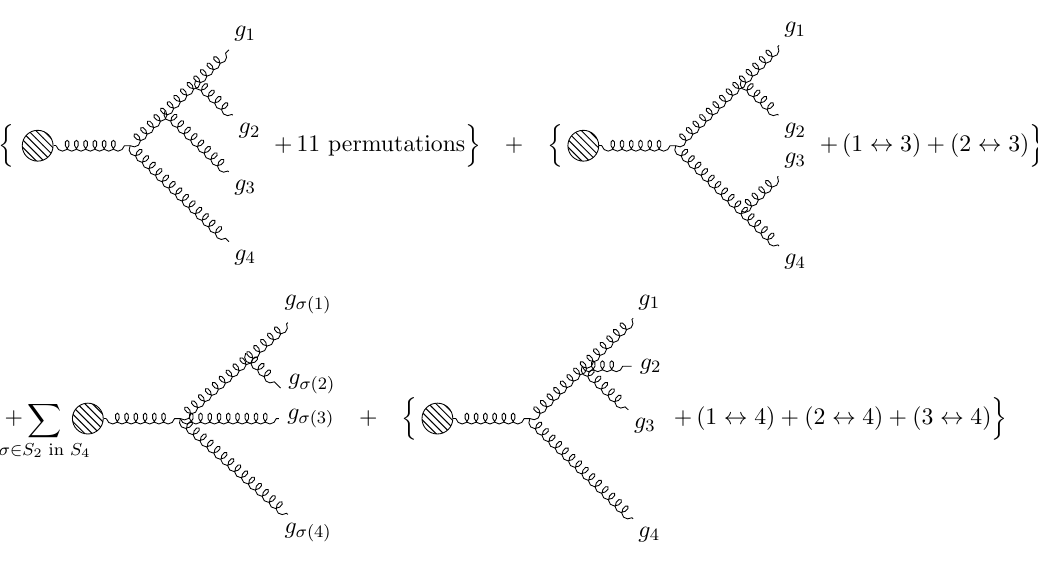
Figure 3 . The diagrams contributing to the splitting process g ! g 1 g 2 g 3 g 4 . In the third diagram we sum over the 6 possible pairings of the partons in the three-gluon